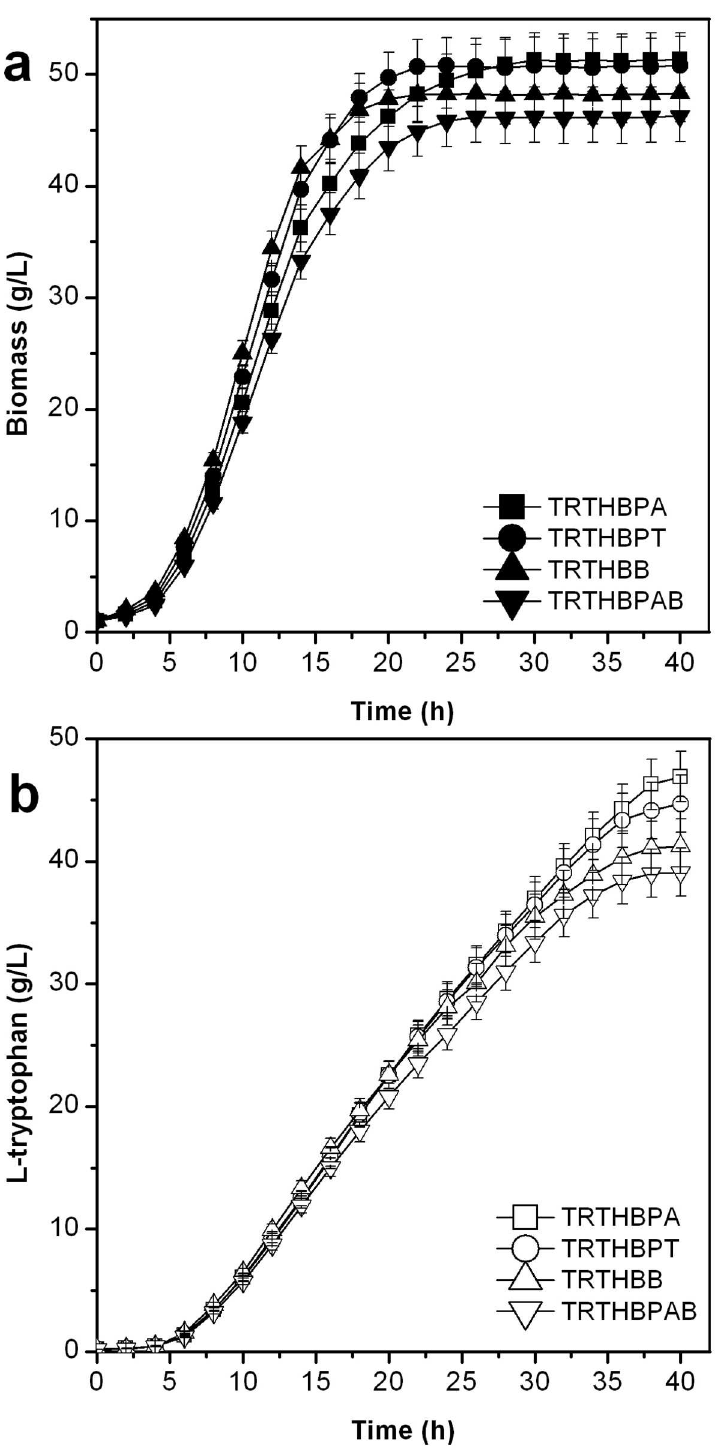
Fig 3. Effect of modifying the genes required for acetatesynthesis on biomass and production of L- tryptophan in L-tryptophan fermentation ( P < 0.05).